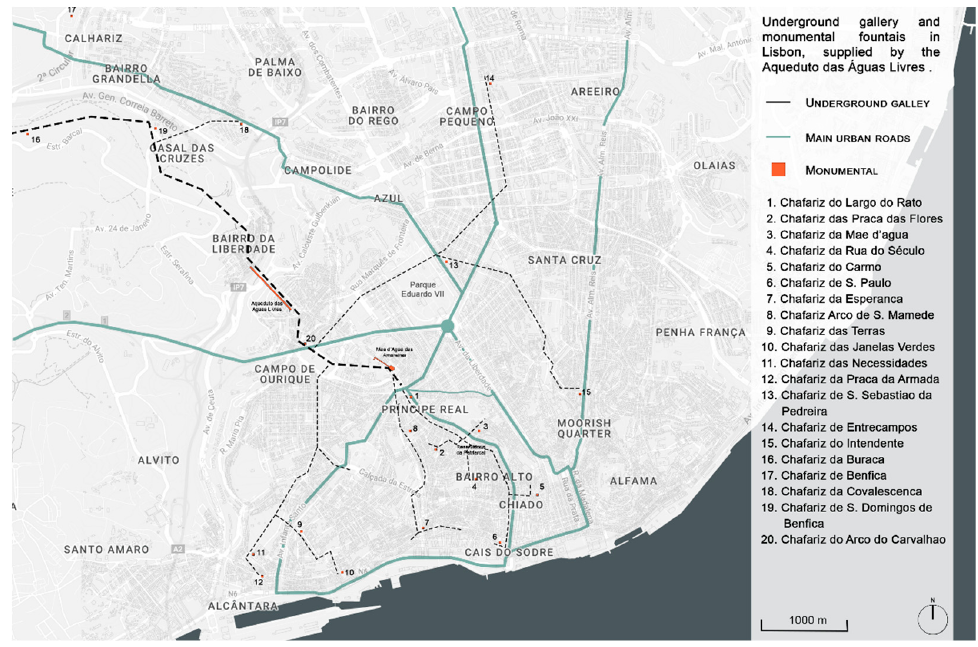
Figure 2. Map of the underground galleries belonging to the Lisbon aqueduct (© L. Gorgoglione).